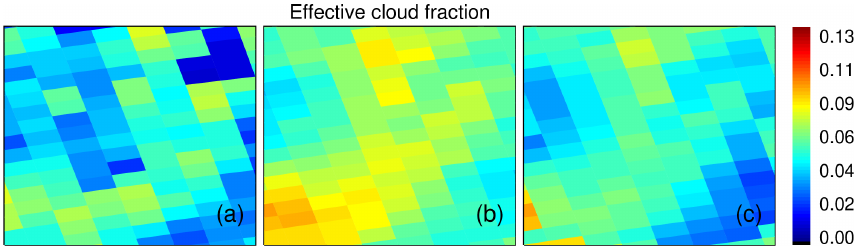
Figure 7. ECF retrieved with climatological surface LER (a) , retrieved with GLER and implicit aerosol correction (b) , and retrieved with GLER and explicit aerosol correction (c) over the selected area for OMI orbit 3843 on 5 April 2005.